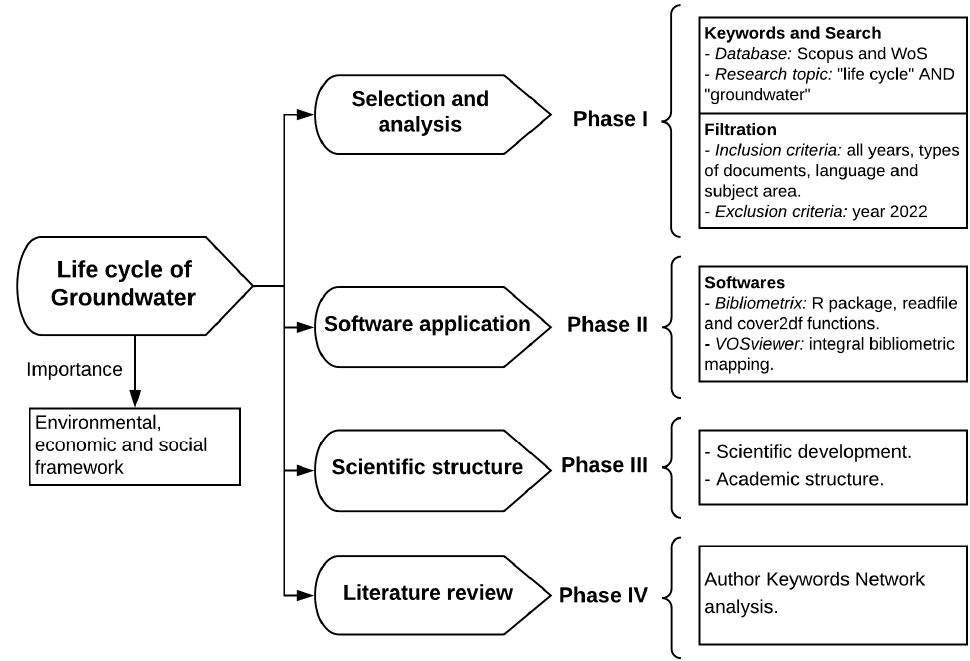
Figure 1. Diagram of study’s methodology. Based on [76,77].